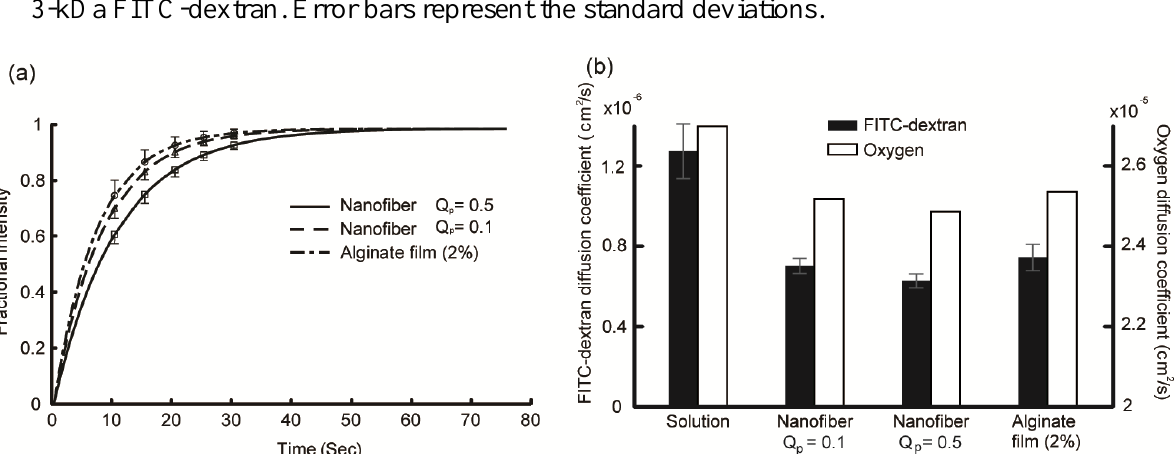
Figure 2. Results of fluorescence recovery after photobleaching (FRAP) measurements. ( a ) Fractional fluorescence intensity recovery curves at flow rates of 0.5 and 0.1 mL/h electrospun line patterns and the 2% calcium alginate hydrogel. Error bars represent the standard deviations; ( b ) Diffusion coefficients of 3-kDa FITC-dextran and oxygen in the electrospun line patterns, 2% calcium alginate hydrogel, and water at 37 °C. Oxygen diffusion coefficients are estimated values from Equation 2 and the diffusion coefficient of 3-kDa FITC-dextran. Error bars represent the standard